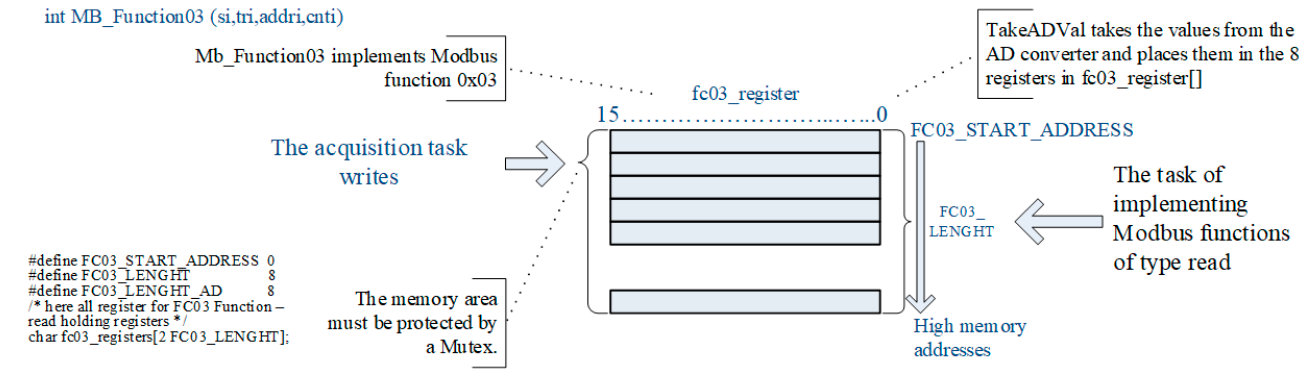
Figure 3. Registers attached to Modbus function MB_Function03.